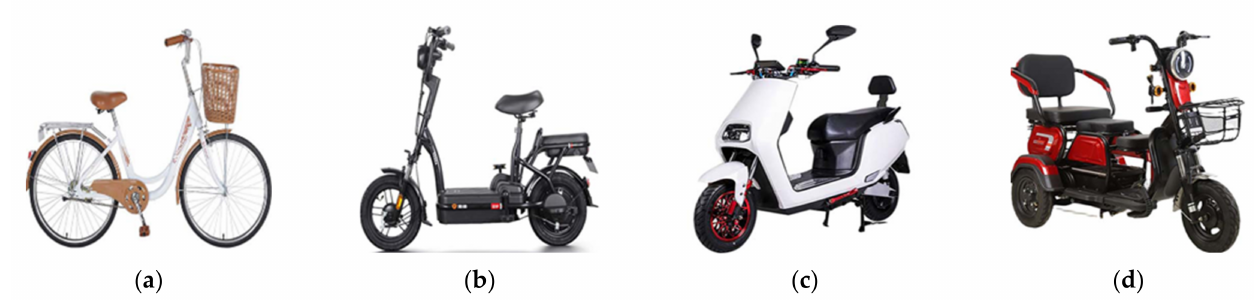
Figure 2. Bike types: ( a ) Bicycle; ( b ) E-bike; ( c ) E-scooter; ( d ) Electric tricycle. Road geometric design. The geometric design of the road includes the bike lane width, motorized vehicle lane.